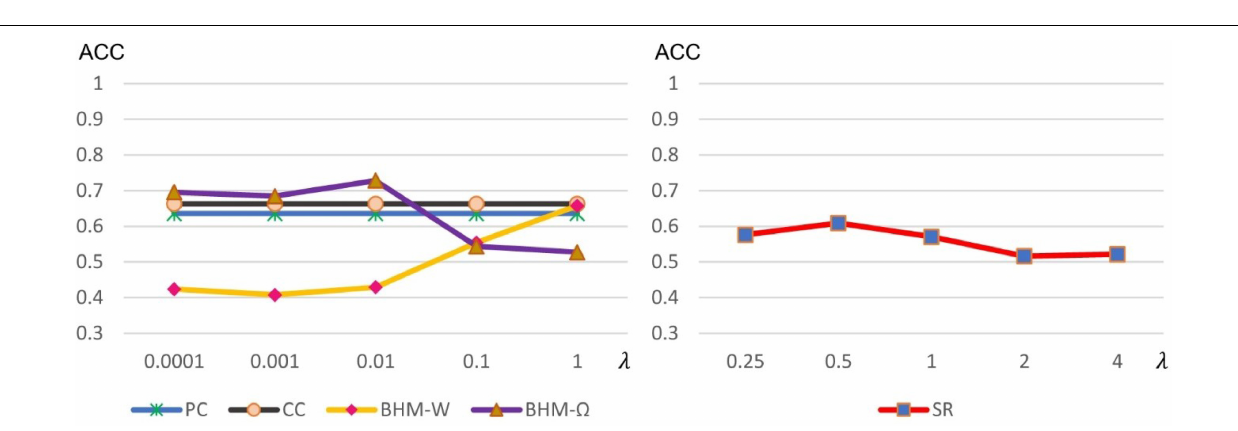
a larger lambda range [ 2 − 5 , 2 − 4 , · · · , 2 0 , · · · , 2 4 , 2 5 ] and find